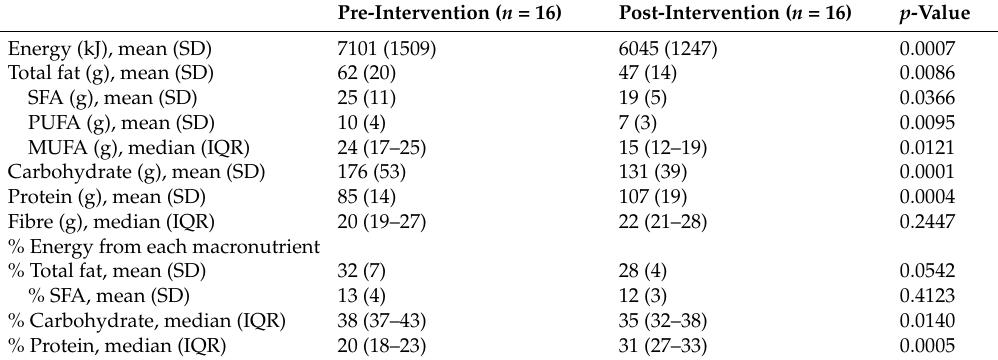
Table 2. Intake of selected macronutrients before and after the weight loss intervention, as determined by self-reported four-day semi-quantitative food diaries. ( n =